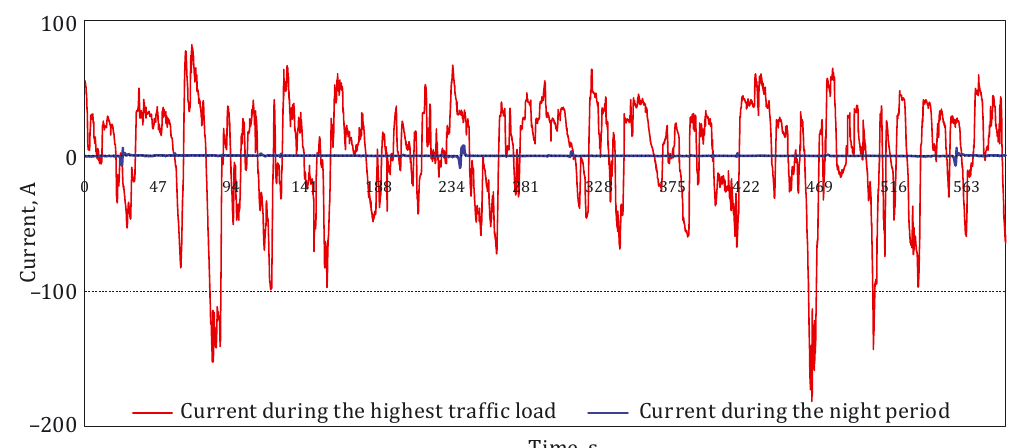
Figure 8. Results of stray current field measurement in the measuring point with very high tram traffic, measurement conducted during the rush hours and at night when tram traffic is not